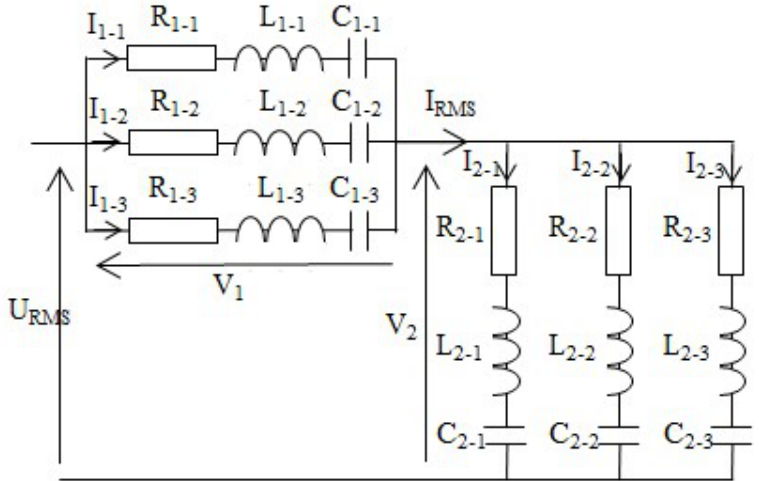
Figure 7. Three RLC branches associated in series with three other parallel RLC branches’ circuit